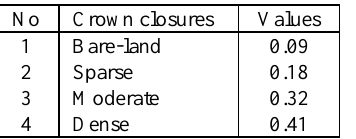
Table 11. The weighted values of crown closure Tree Stages Values